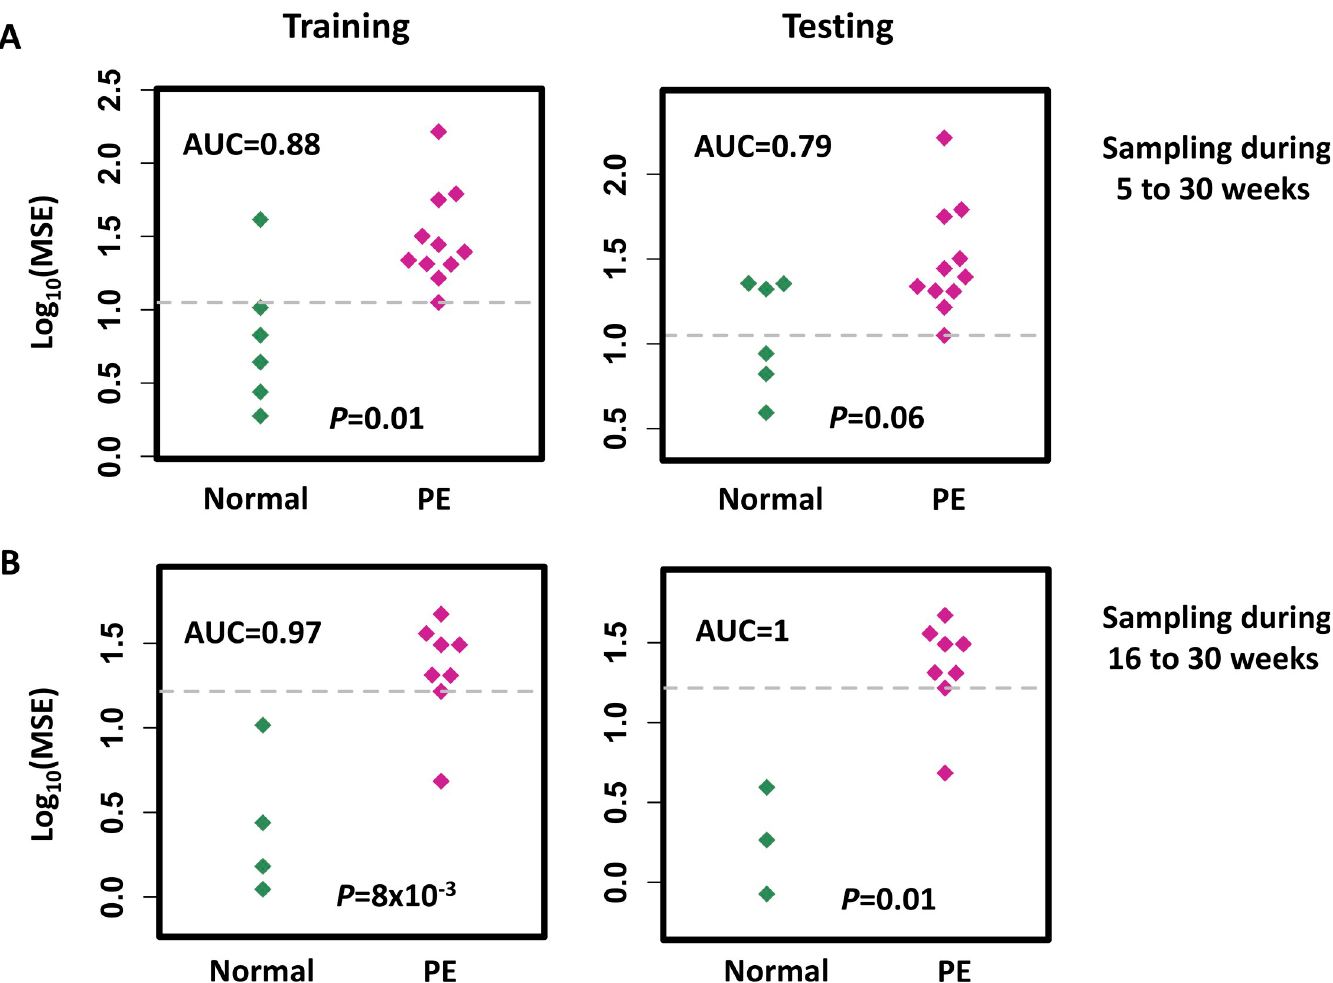
Fig 4. The mean squared error (MSE) of the EN model in estimating the GA of normal and PE patients in the training and testing cohorts, respectively. Mann- Whitney U-test P-value was calculated to measure the difference in MSE between the normal and PE patients. The cut-off point (grey dotted line) shows the maximum value of the sum square of the sensitivity and 1-specificity on classification of the training cohort of normal and PE women at blood sampling during (A) 5–30 and (B) 16–30 weeks of